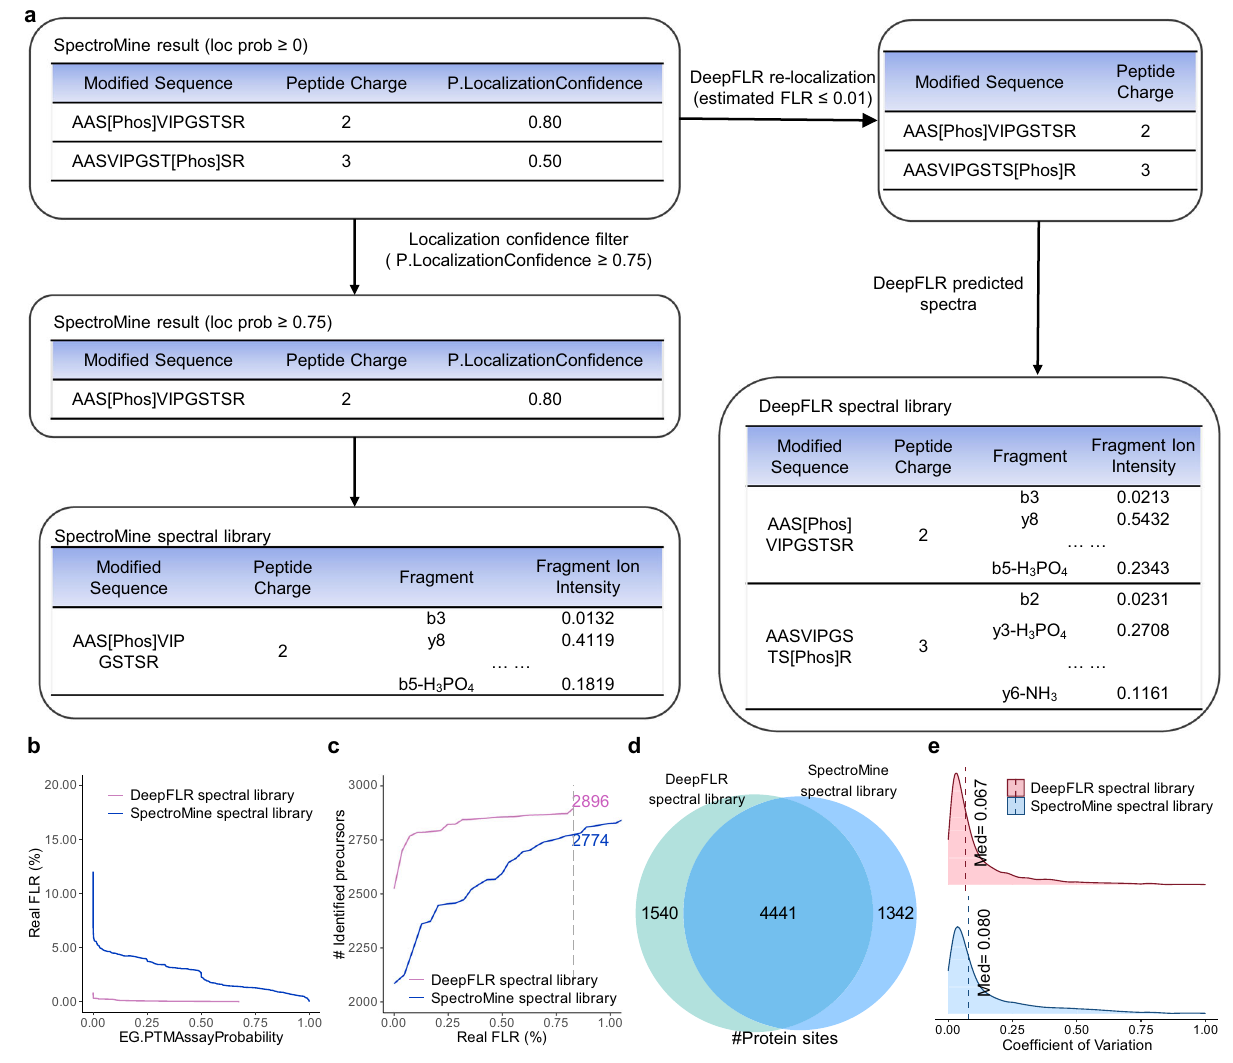
Fig. 5 | DIA analysis using DDA-based experimental spectral library and pre- dicted spectral library by DeepFLR. a Schematic illustration of the spectral libraries construction. Identi fi cation of phosphopeptides from a synthetic phos- phopeptides dataset DIA_1 using DeepFLR predicted spectral library and SpectroMine-based experimental spectral library, considering b the correlation betweenrealFLRandEG.PTMAssayProbabilityscorebySpectronautanalysisofthe DIA data, and c the correlation between real FLR and identi fi ed phosphopeptides